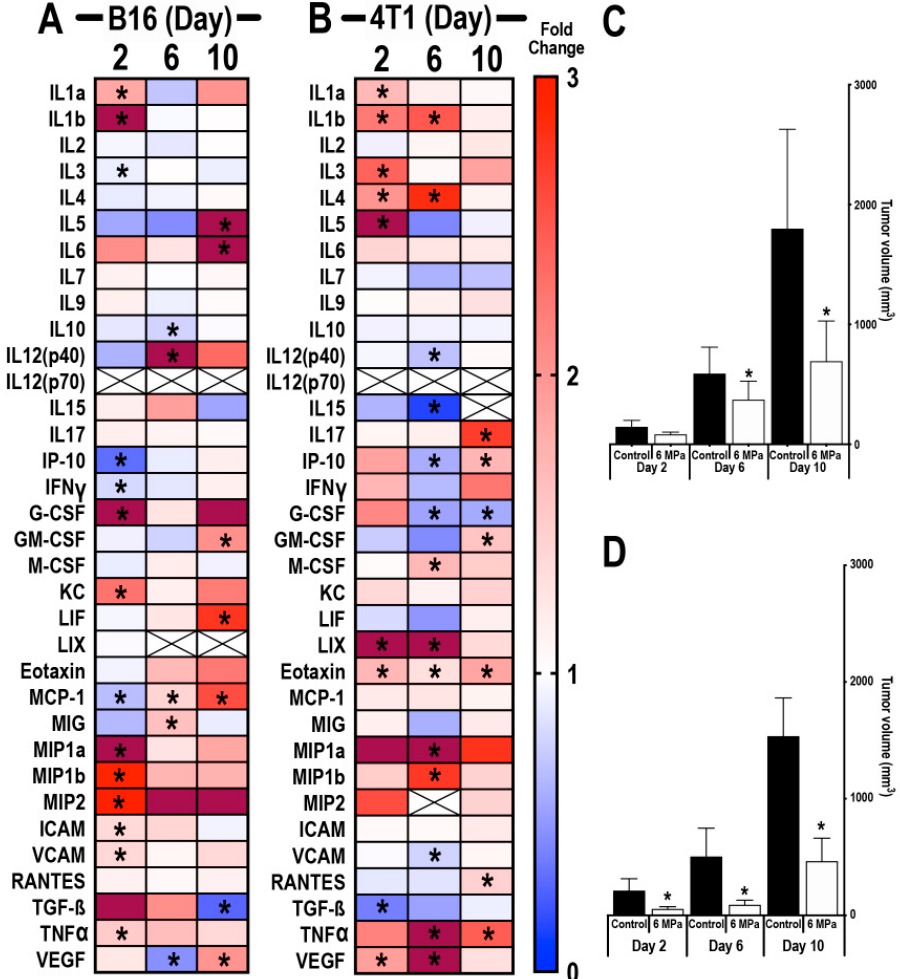
Figure 2. Proteomic response of B16 or 4T1 tumors following pulsed focused ultrasound (pFUS) treatment on di ff erent growth progressions. Heat map depicting fold changes in CCTFs 24 h post-sonication of mouse B16 ( A ) or 4T1 ( B ) tumors on days 2, 6, or 10. Tumors from non-sonicated control mice on days 2, 6, and 10 served as time-matched controls. Protein levels are presented as fold changes in relation to time-matched non-sonicated control values. Blue represents fold changes less than 1. Red represents 1–3 fold changes. Dark red represents fold changes > 3.1. Tumor size volumes of mouse xenograft B16 melanoma ( C ) or 4T1 breast cancer ( D ) model; asterisks indicate statistical significance ( p < 0.05) identified by ANOVA test.